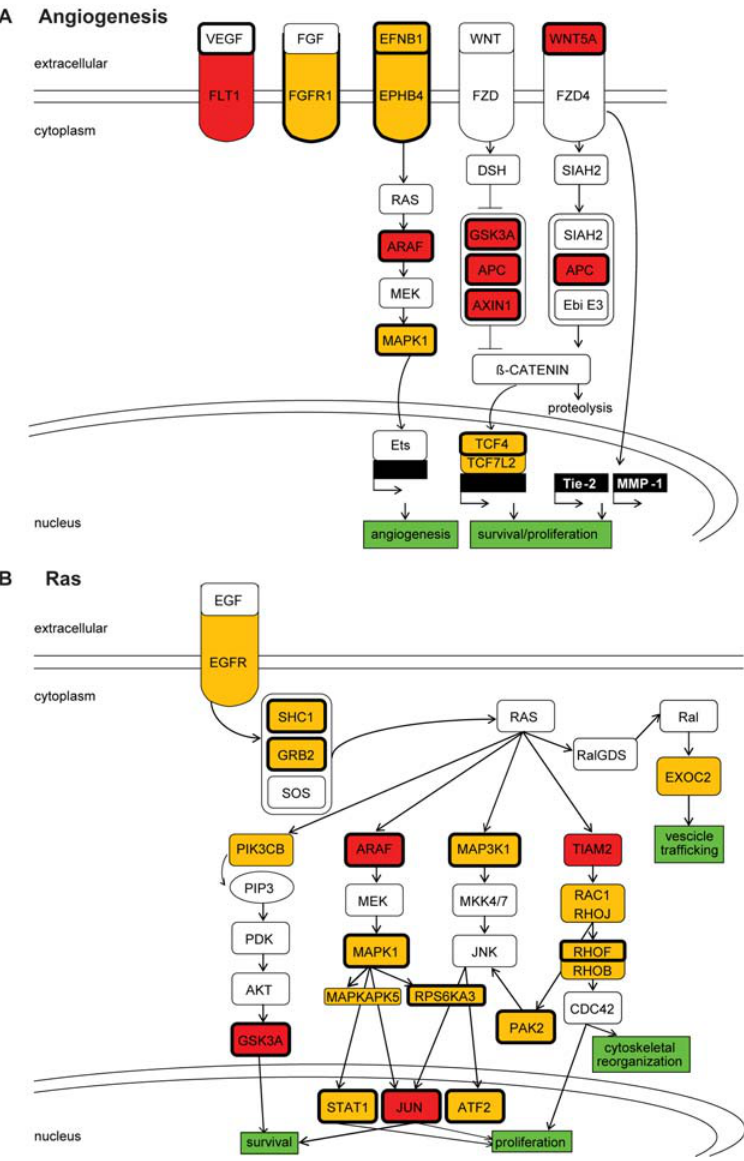
Figure 2. PUM targets encode proteins acting in cancer related pathways. Components whose mRNAs are associated with PUM1 are depicted in yellow, those bound by both PUM1 and PUM2 are shown in red. Messages that contain a PUF motif are shown with a thick black border. (A) Regulators of angiogenesis. PUM associated messages code for the tyrosine kinase receptors fms-related tyrosine kinase 1 (FLT1), which is the vascular endothelial growth factor receptor 1, fibroblast growth factor receptor 1 (FGFR1) and EPH receptor B4 (EPHB4) and its ligand ephrin-B1 (EFNB1). These receptors and their ligands can trigger signals that induce angiogenesis [73,74,75]. ARAF (v-raf murine sarcoma 3611 viral oncogene homolog) and MAPK1 (mitogen-activated protein kinase 1) are part of the RAS/RAF/MAPK pathway that can activate ETS (E26 transformation specific sequence) family transcription factors that promote angiogenesis [76]. Human PUM proteins commonly target messages of both canonical (Wnt/ß- catenin) and non-canonical (Wnt/calcium signaling and planar cell polarity) pathways: WNT5A (wingless-type MMTV integration site family, member 5A) activates non-canonical Wnt signaling [77], which induces proliferation of endothelial cells in vitro . WNT5A is thought to promote the expression of the angiogenic effectors MMP1 (matrix metallopeptidase 1), and TEK (endothelial TEK tyrosine kinase, TIE-2) [77]. PUM1 and PUM2 commonly target components of the ‘‘ß-catenin destruction complex’’ consisting of the serine/threonine kinase GSK3A (glycogen synthase kinase 3 alpha), which phosphorylates ß-catenin marking the protein for ubiquitylation and rapid degradation by the proteasome, the tumor suppressor APC (adenomatous polyposis coli), and the scaffold protein AXIN1. PUM1 further associates with mRNAs coding for the co-factors TCF/LEF1 (transcription factor/lymphoid enhancer-binding factor 1) that become activated when ß-catenin enters the nucleus. This includes TCF4 and TCF7L27 (transcription factors 4 and 7-like 2), that stimulate the transcription of genes implicated in cell growth regulation [50]. (B) Activators and effectors of RAS [49,78]. PUM bound messages code for EGFR (epidermal growth factor receptor), adaptor proteins GR B2 (growth factor receptor-bound protein 2) and SHC1 (Src homology 2 domain containing transforming protein 1), which activate Ras proteins upon recruitment of the guanine nucleotide exchange factor SOS (son of sevenless). RAS interacts specifically with ARAF, MAP3K1 (mitogen-activated protein kinase kinase kinase 1), PIK3CB (phoshoinositide-3- kinase, catalytic, beta polypeptide) and TIAM2 (T-cell lymphoma invasion and metastasis 2), which can initiate cascades of protein-protein interactions and further activate more specific signaling pathways. Components of the Raf/MEK/ERK and the MEKK/SEK/JNK pathways are covered by PUM1 targets encoding mitogen-activated protein kinases MAPK1 and MAPKAPK5 (mitogen-activated protein kinase-activated protein kinase 5), and RPS6AK3 (ribosomal protein S6 kinase, polypeptide 3). These pathways target the transcription factors JUN (jun oncogene), ATF2 (activating